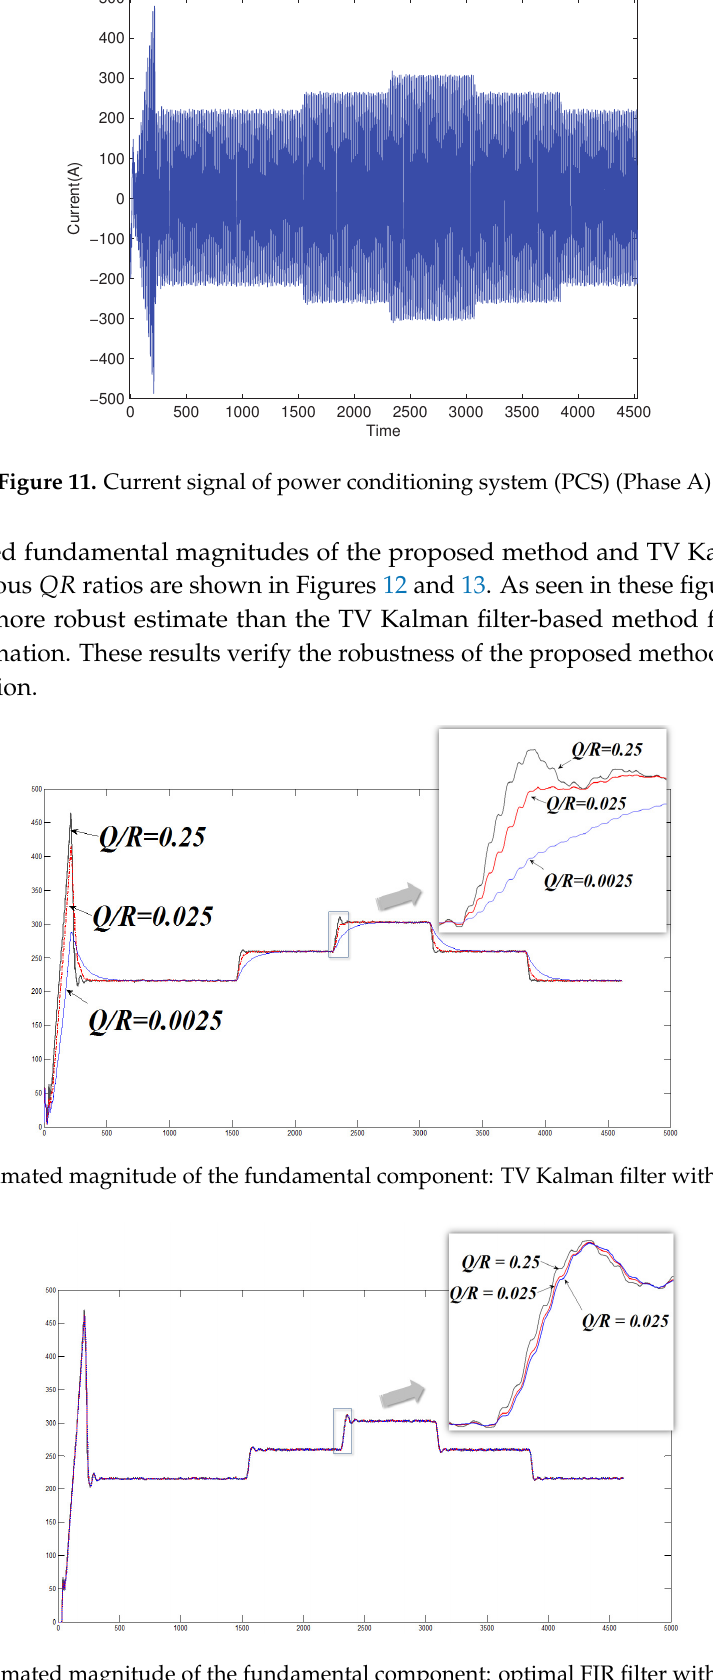
Figure 13. Estimated magnitude of the fundamental component: optimal FIR filter with various Q / R